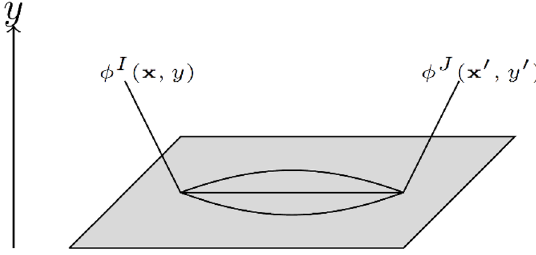
Figure 5 . Bulk two-point function at leading non-trivial order with (cid:30) 4 interaction on the boundary.